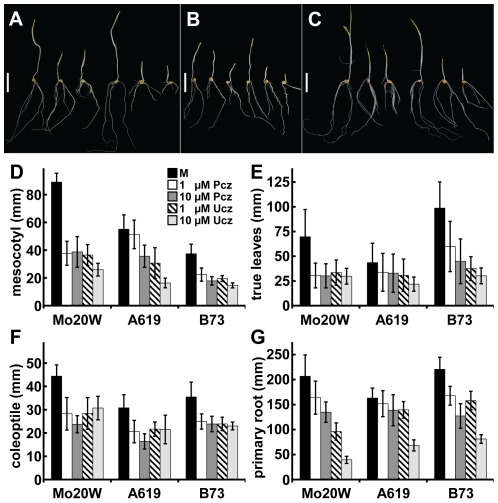
Impact of the genetic diversity on the tissue specific sensitivity towards Pcz and Ucz.(A–C) Maize inbred seedlings (A) Mo20W, (B) A619, and (C) B73 grown in vermiculite for 8 d at 29°C in the dark treated with (left to right): 0 µM Pcz, 1 µM Pcz, 10 µM Pcz, 0 µM Ucz, 1 µM Ucz, and 10 µM Ucz, respectively. (D–G) Length of the (D) mesocotyl, (E) true leaves, (F) coleoptile, and (G) primary root of Mo20W, A619, and B73 maize seedlings treated with 0 µM Pcz, 1 µM Pcz, 10 µM Pcz, 0 µM Ucz, 1 µM Ucz, or 10 µM Ucz, respectively (n>15). (D–G) Error bars represent standard deviation. Statistical analysis determined by “Post-hoc” test is shown in Table S2 (p<0.05). Scale bar (A–C) 6 cm.